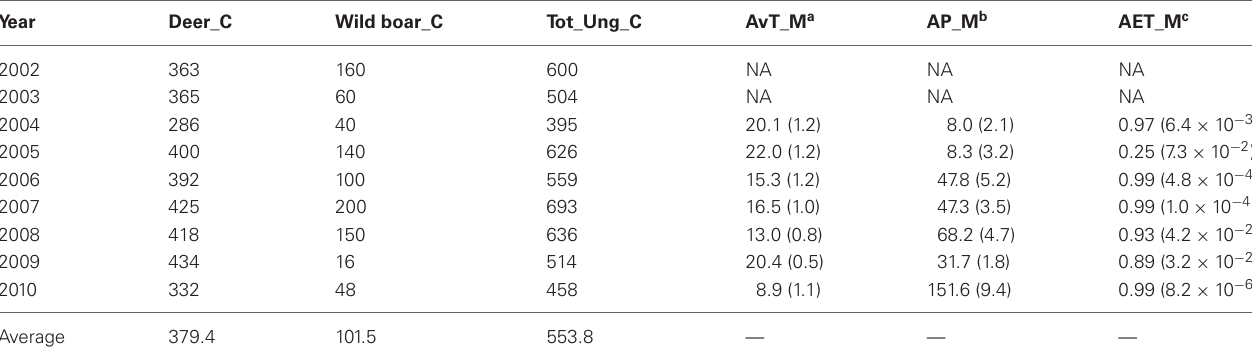
Table 2 | Deer, wild boar, total ungulate (deer + boar + mouflon + aoudad) counts, and average values of climatic variables (and associated standard error within brackets) associated to deer sampling date in the hunting estate throughout